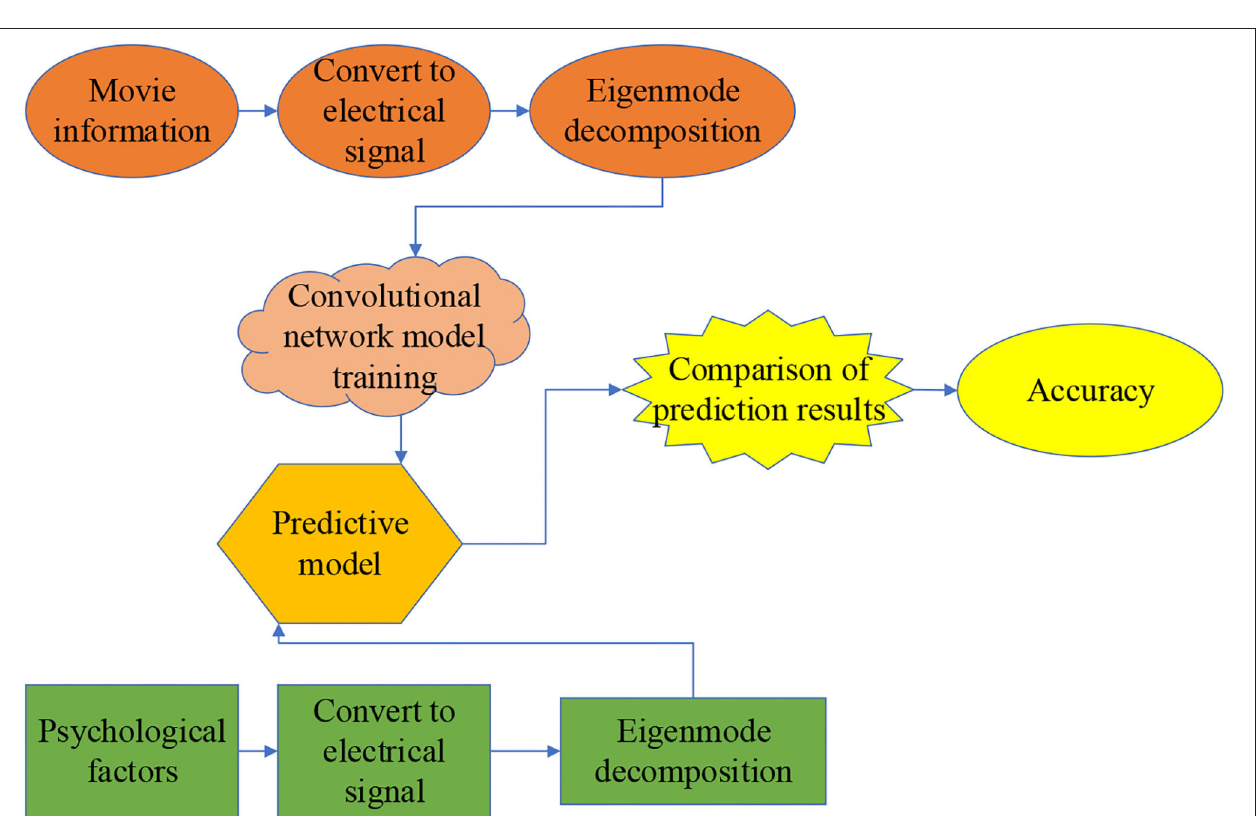
FIGURE 5 | Training model of the separable deep convolutional neural network